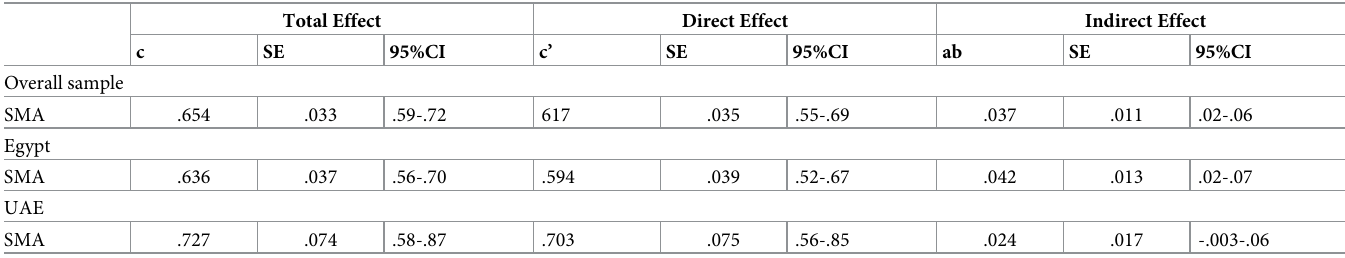
Table 3. Estimated coefficients of the tested mediation models, overall sample and for each country (outcome: Social media